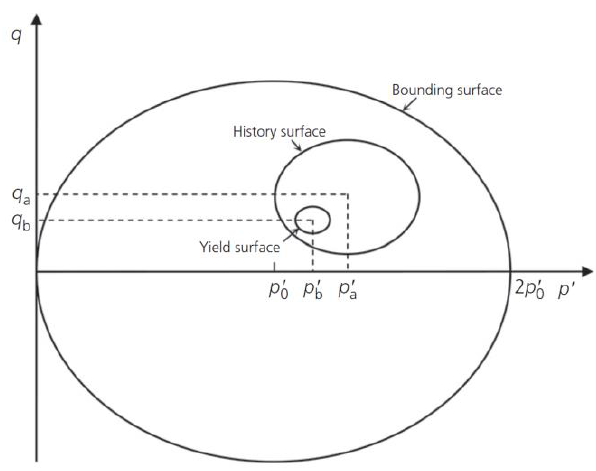
Figure 1. The 3SKH model surfaces in the q − ’ plane (after [7]).